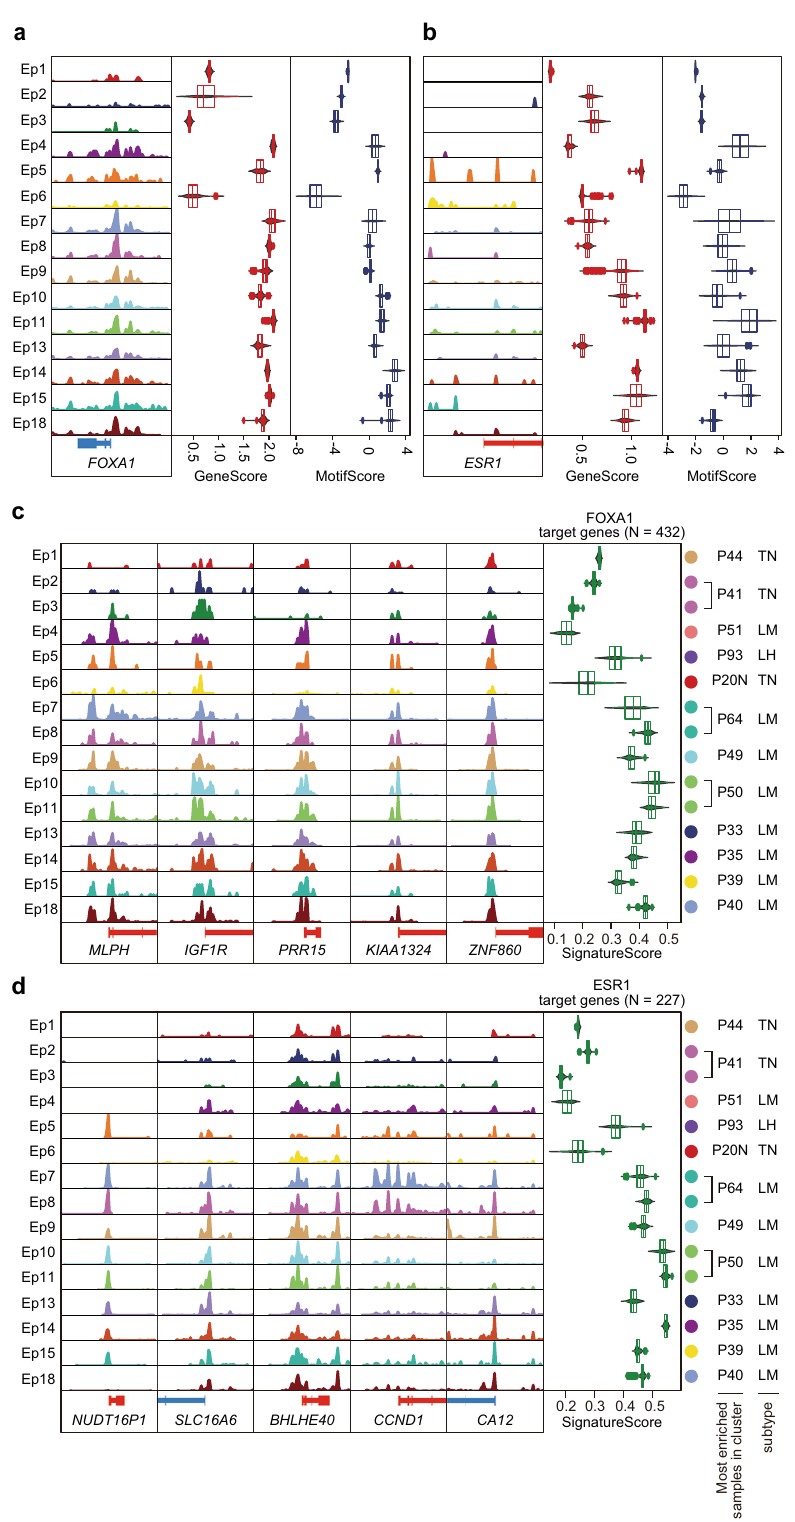
Fig. 4 Gene activity signatures of FOXA1 and ER targets. a , b Aggregated ATAC signal tracks around TSS (left), gene activity scores (center), and motif enrichment scores (right) of FOXA1 in a and ESR1 in b for each cancer cluster. c , d Aggregated ATAC signal tracks around TSSs of the represented targets (left) and signature scores (right) of genes targeted by FOXA1 in c , ER in d for each cancer